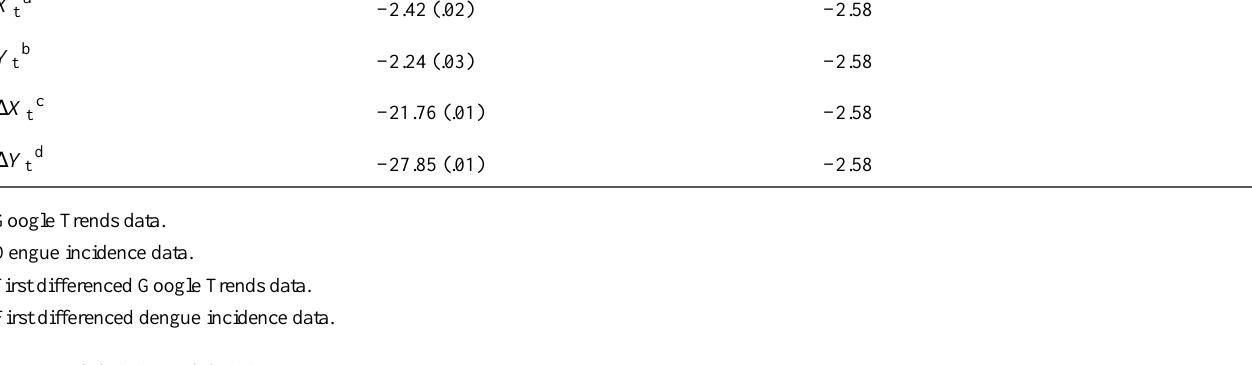
Figure 2. (A) {X t } and (B) {Y t } plots with one-time difference. X t : Google Trends data; Y t : dengue incidence